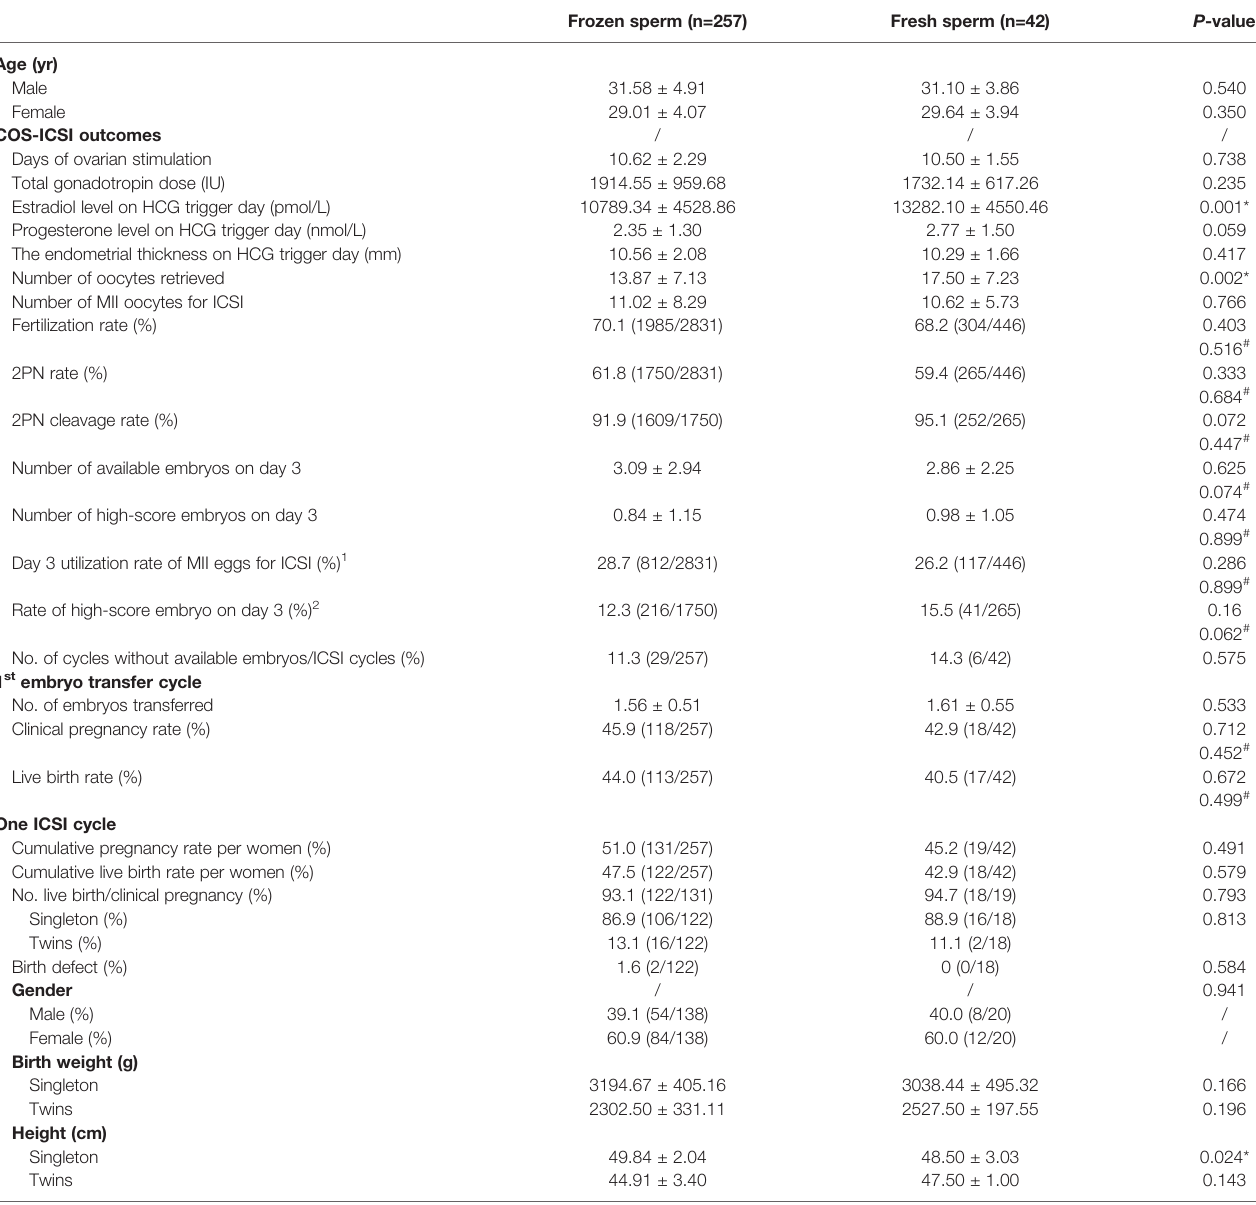
TABLE 3 | Comparison of the ICSI outcomes between frozen and fresh sperm.